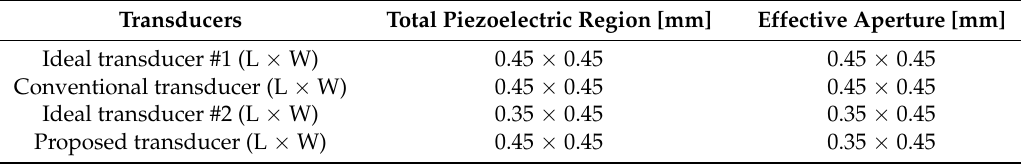
Table 2. Dimension information of four transducers used in FEA simulation.